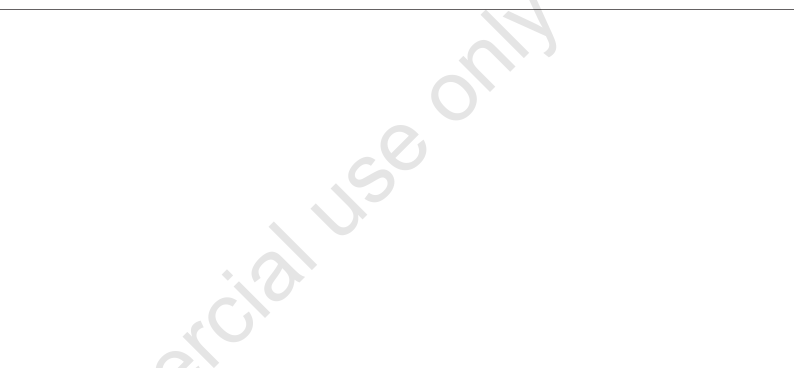
Figure 1. Reports of shingles at diagnosis of common variable immunodeficiency/IgG subclass deficiency (CVID/IgGSD) in 212 adult index